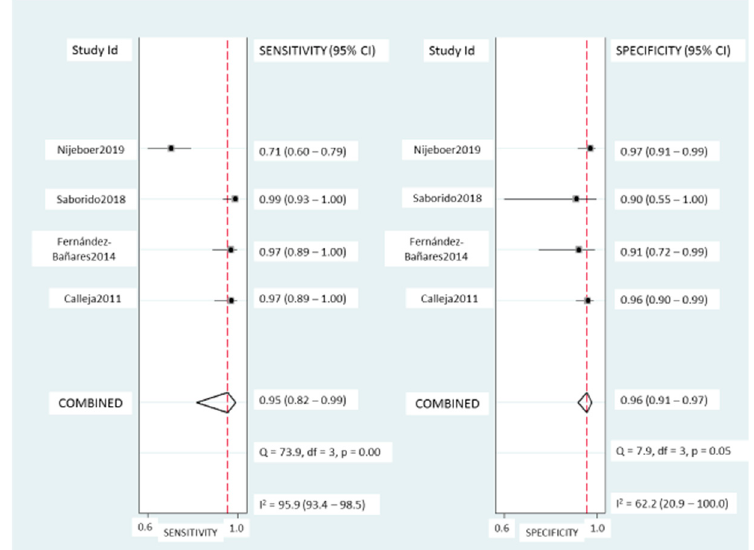
Figure 5. Forest plots showing the pooled sensitivity and specificity of the TCR γδ + count for coeliac disease diagnosis.